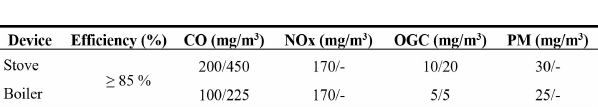
Table 5. Exceptional German award "The Blue Angle" (at 12% O2, normal load / part load).